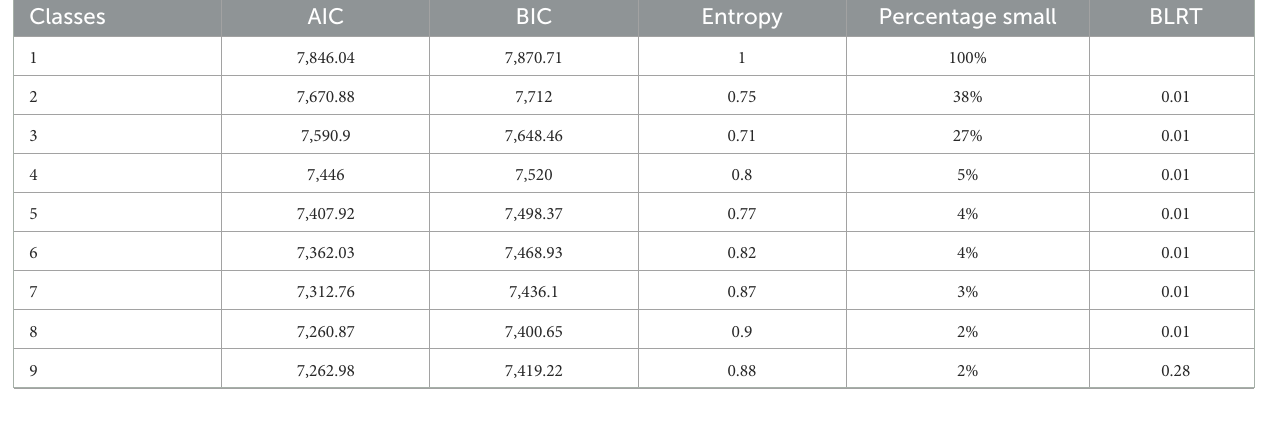
TABLE 3 Fit indices for different models with a number of clusters ranging from 1 to 9.